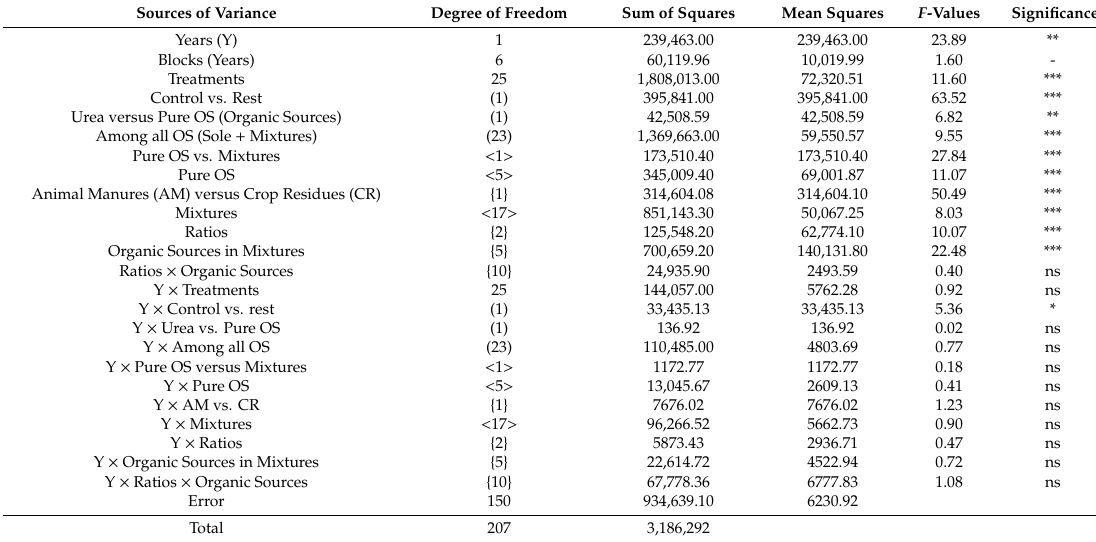
Table 1. Analysis of variance for soil nitrogen concentration (mg kg − 1 ) after harvesting of rice hybrid "Pukhraj” as a ff ected by organic and inorganic